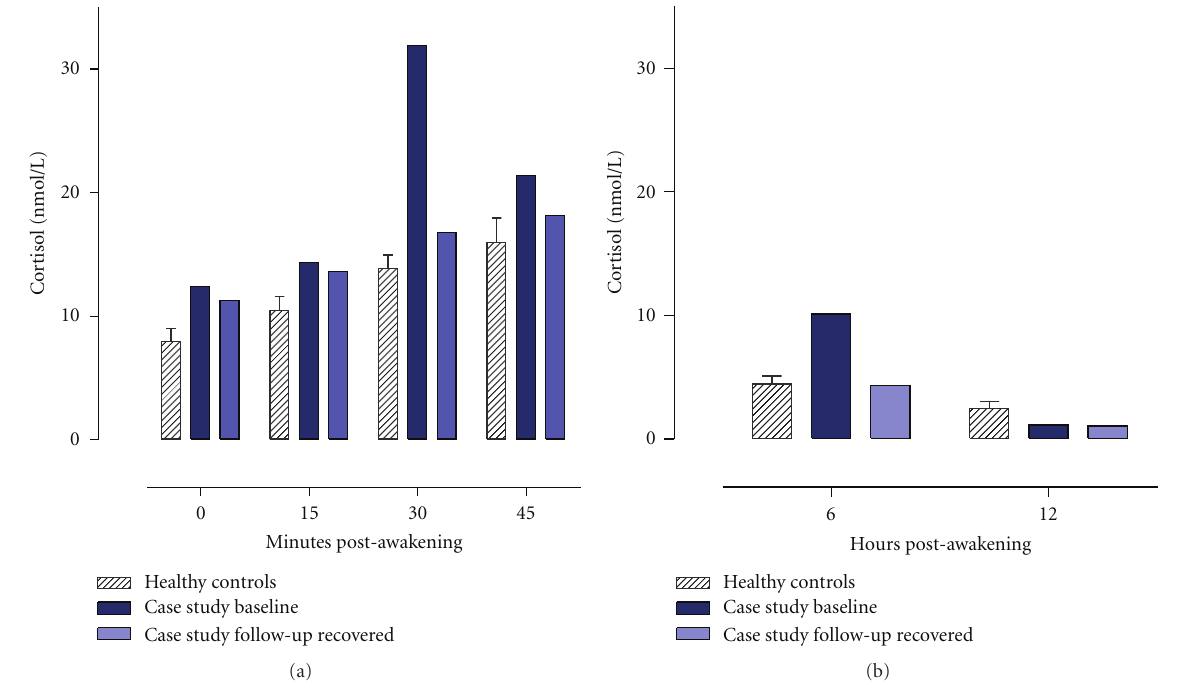
Figure 1: Mean ( ± SEM) salivary cortisol concentrations (nmol/l) after awakening and over the daytime period for the healthy control group ( n = 15) and case study Bella at baseline and when recovered at one year